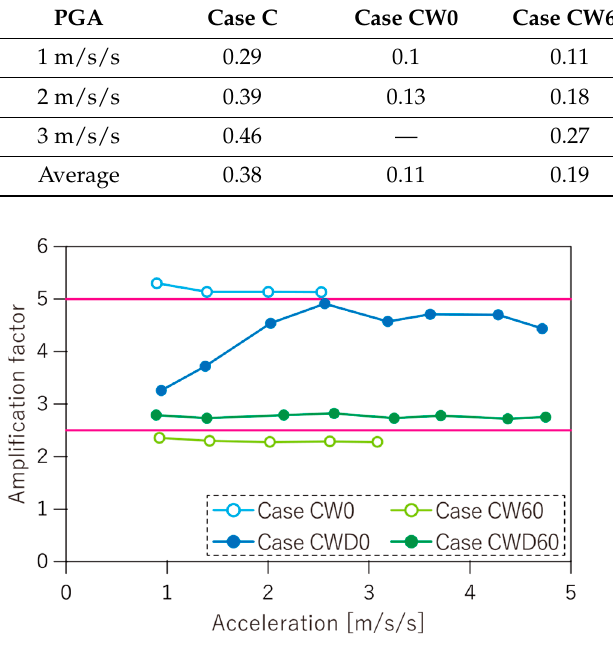
Figure 19. Amplification factor for different